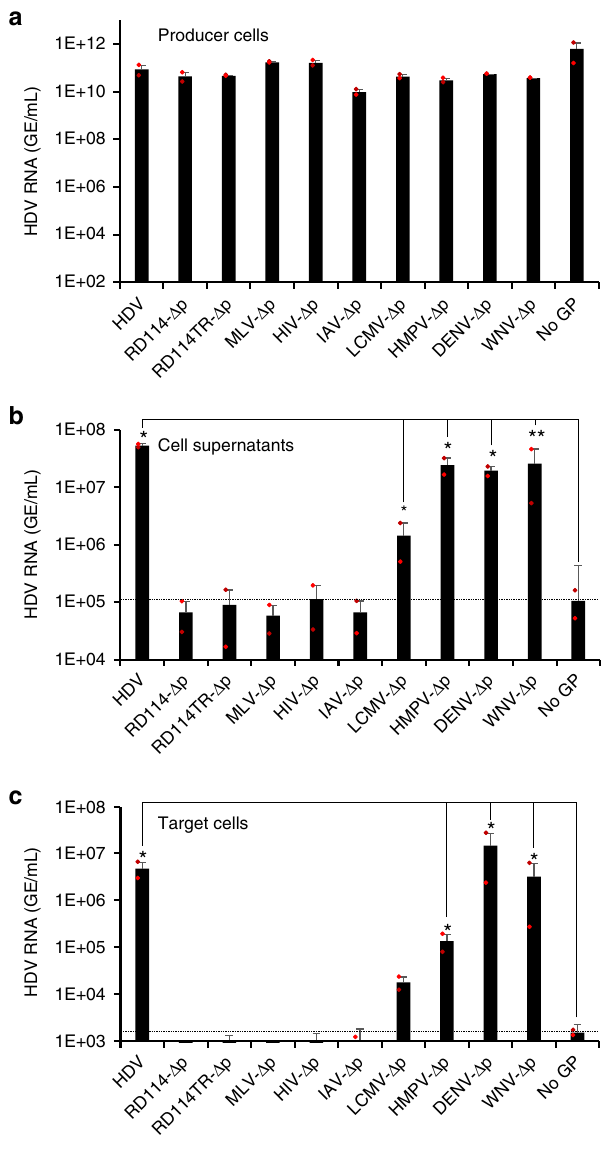
RNAs could be readily detected only in the supernatants from